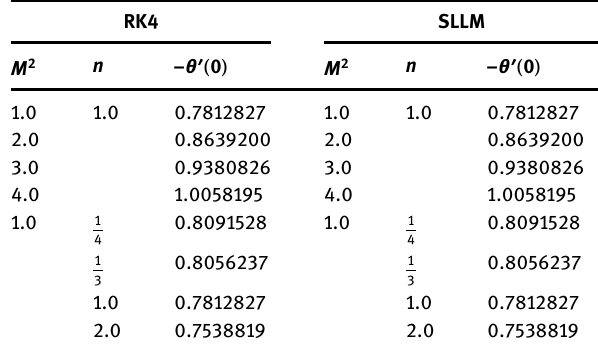
Table 1: Convergence analysis of the SLLM and Runge – Kutta ( RK4 ) for linear and non - linear